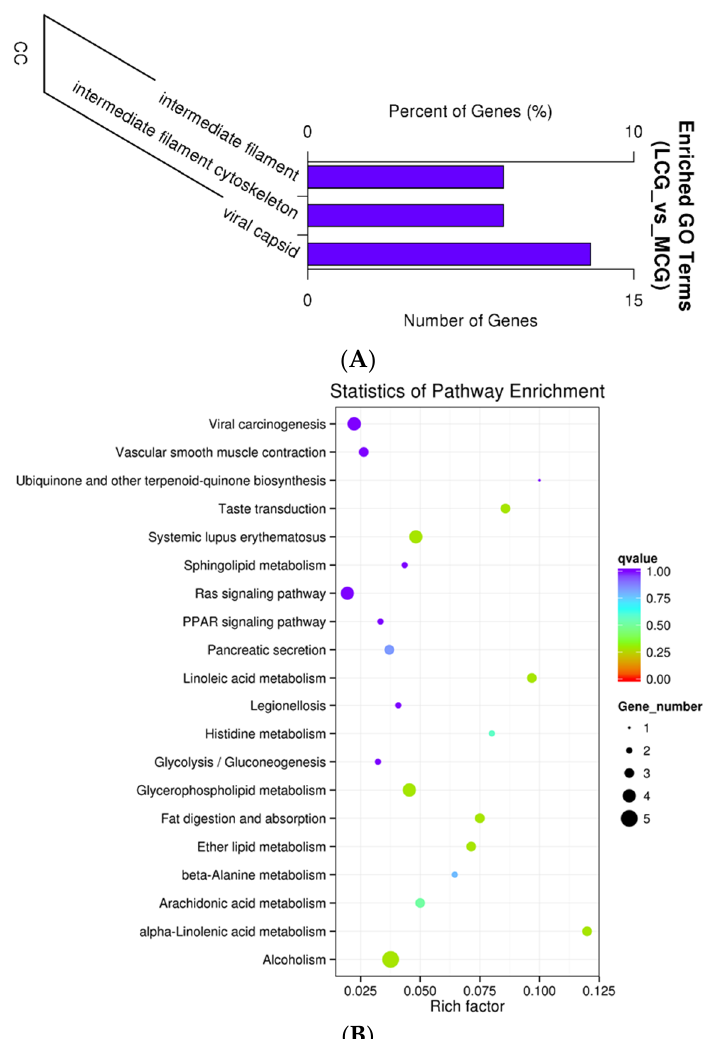
Figure 4. Target genes enrichment analysis. ( A ) GO enrichment analysis for target gene functions of predicted lncRNAs (CC: Cellular component). ( B ) Kyoto Encyclopedia of Genes and Genomes (KEGG) annotation for the target gene functions of predicted lncRNAs. The size of the dot indicates the number of target genes in the pathway, and the color of the dot corresponds to different q-value ranges.